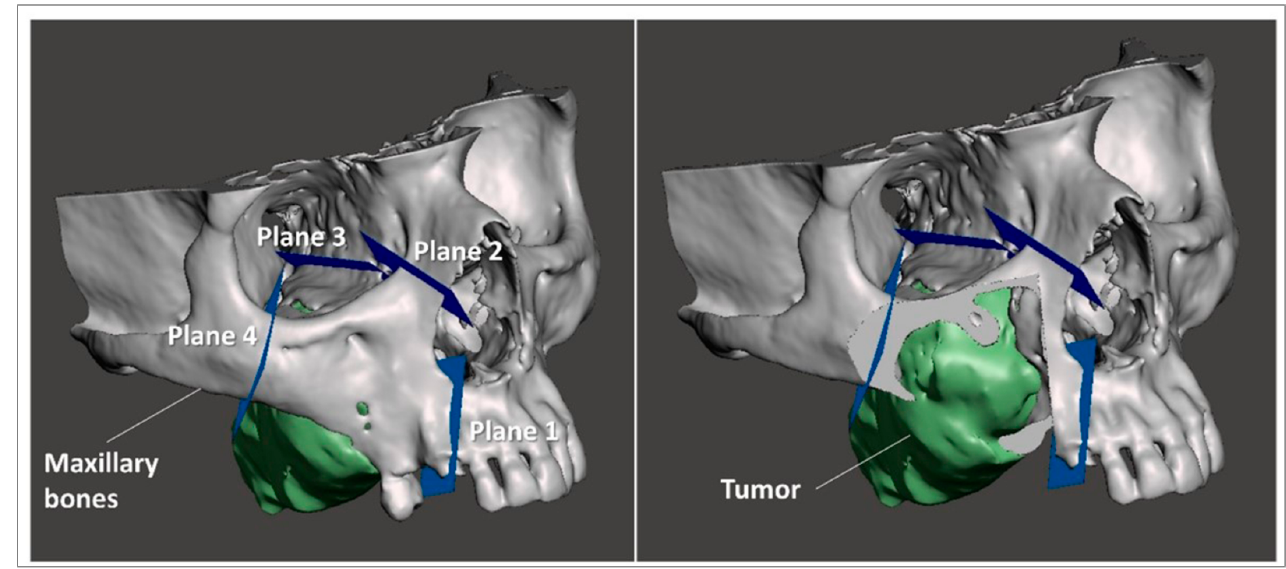
Figure 3. Virtual planes for maxillary bone resections.